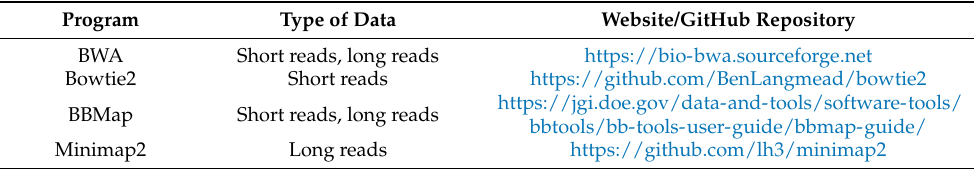
Table 3. Bioinformatic mappers for filtering out untargeted or contaminant sequences in short- read and long-read sequencing data. All websites/GitHub Repository links were accessed on 23 December